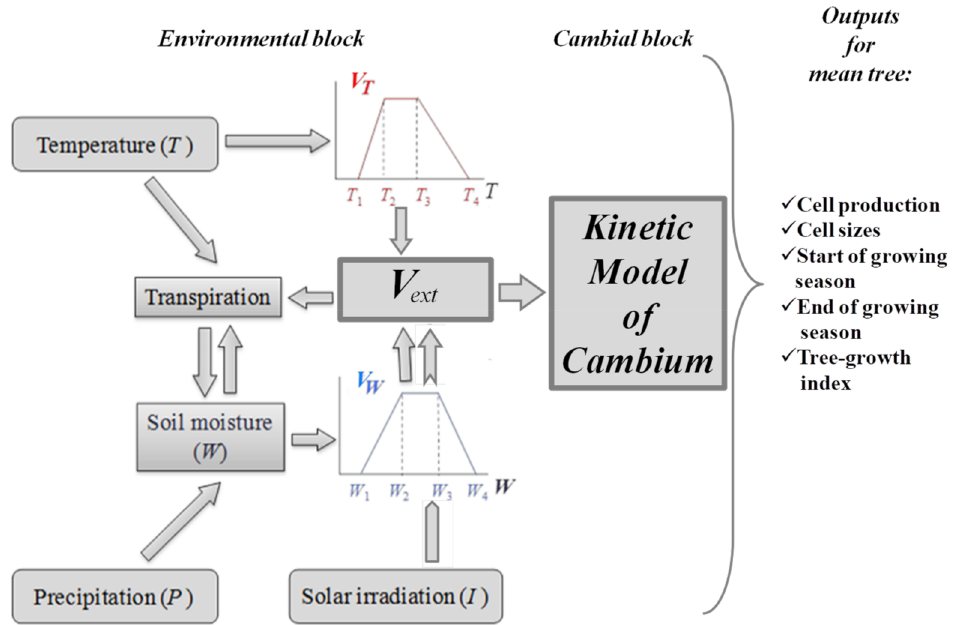
Figure 1. Flowchart of the VS-model algorithm consisting of environmental block, where V ext — integral growth rate and V I ( t ), V T ( t ), V W ( t )—partial growth rates dependent on the solar irradiance (or day length) I , temperature T and soil moisture W , respectively; cambial block and model